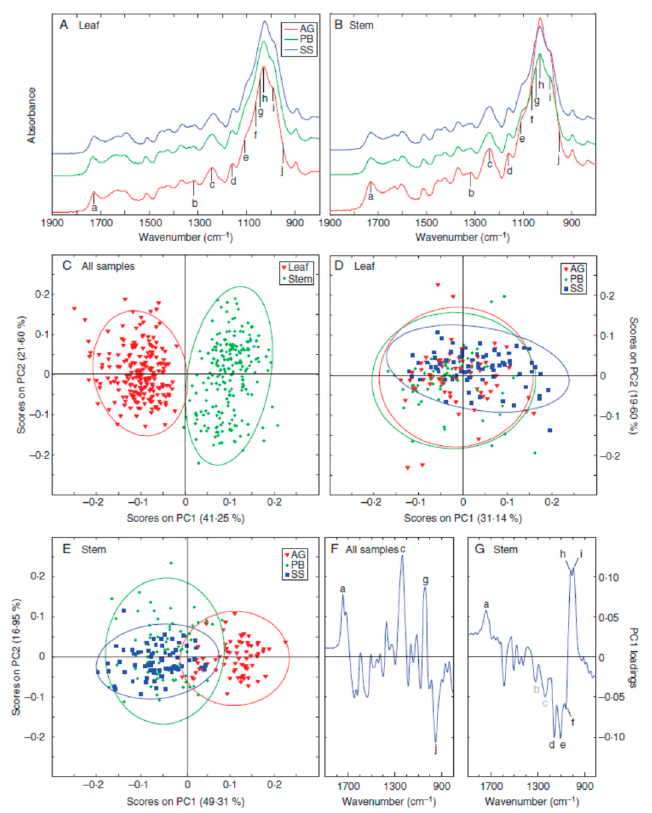
Figure 7. Mean Fourier-transform infrared spectroscopy (FTIR) spectra of ( A ) leaf and ( B ) stem samples of 25 Miscanthus genotypes, at three developmental stages in the range 1900–800 cm − 1 . Plot of principal component one (PC1) and principal component two (PC2) scores for ( C ) all samples, ( D ) leaf samples, and ( E ) stem samples. PC1 loading plot for ( F ) all samples and ( G ) stem samples. Reproduced with permission from [134], Oxford University Press, 2019.